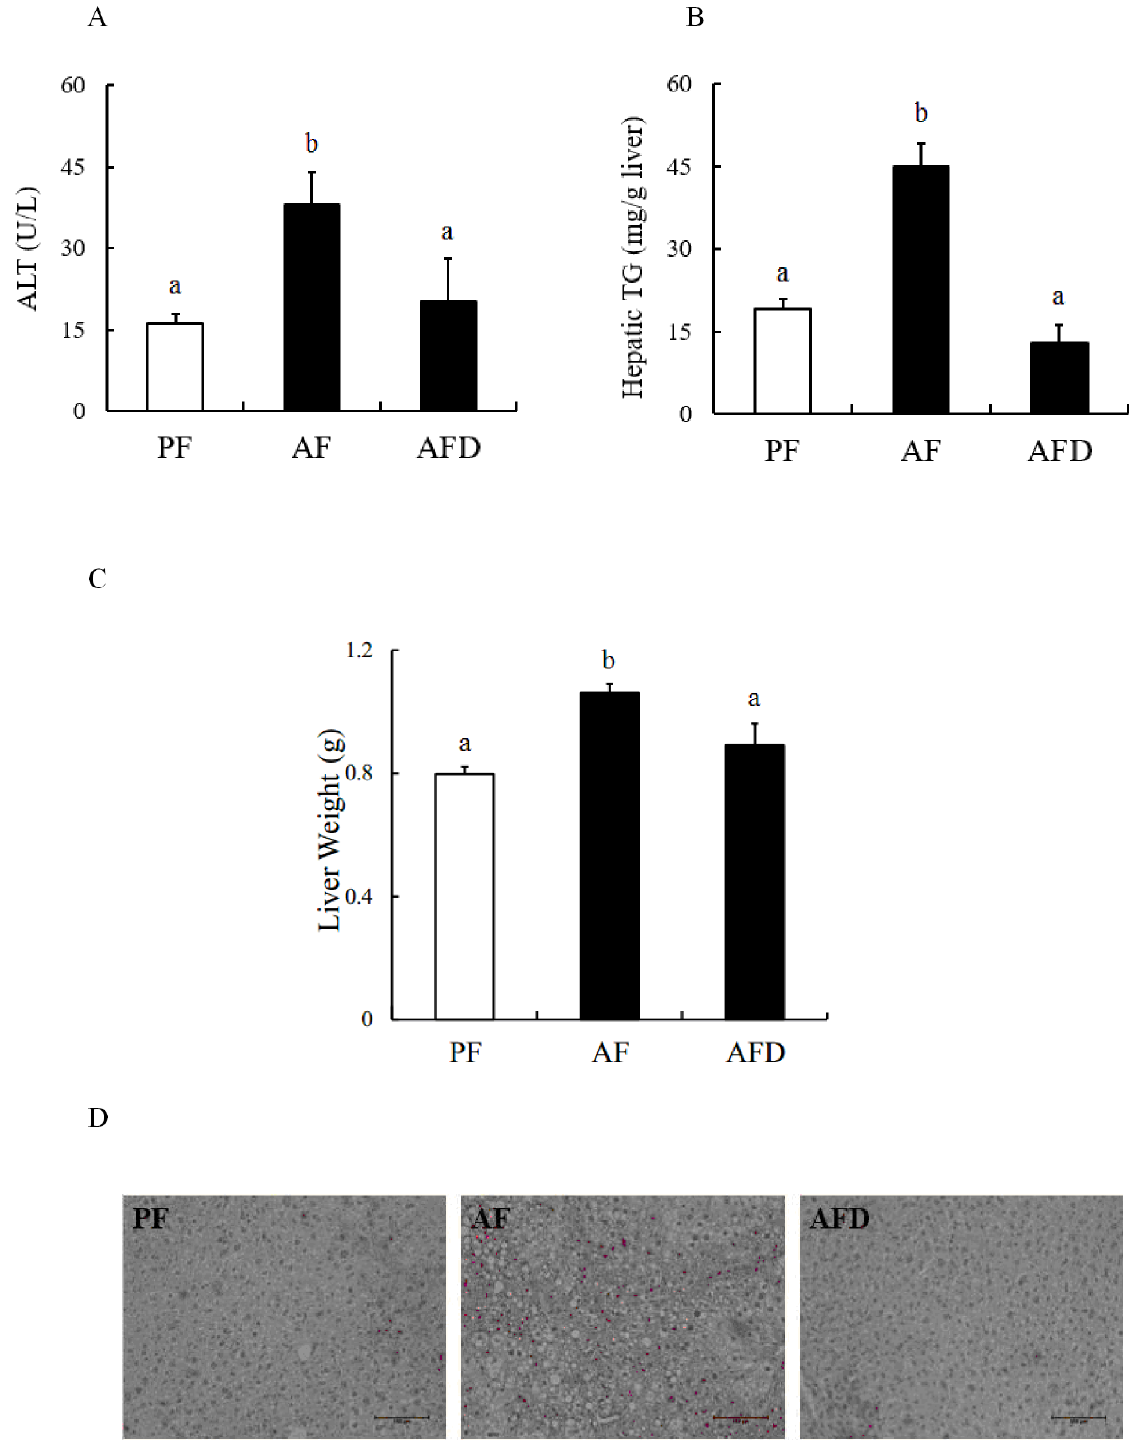
Fig 1. Danshen alleviates liver injury and intrahepatic TG accumulation resulted from chronic alcohol exposure. A . Serum alanineaminotransferase (ALT) levels. B . Hepatic triglyceride(TG) contents. C . Liver weights. D . H&E staining of liver tissues. Data are expressedas the mean ± SD (n = 8 mice per group). Bars with different letters differ significantly (p < 0.05). PF: pair feeding; AF: alcoholfeeding; AFD: alcoholfeedingwith Dansheninjection.